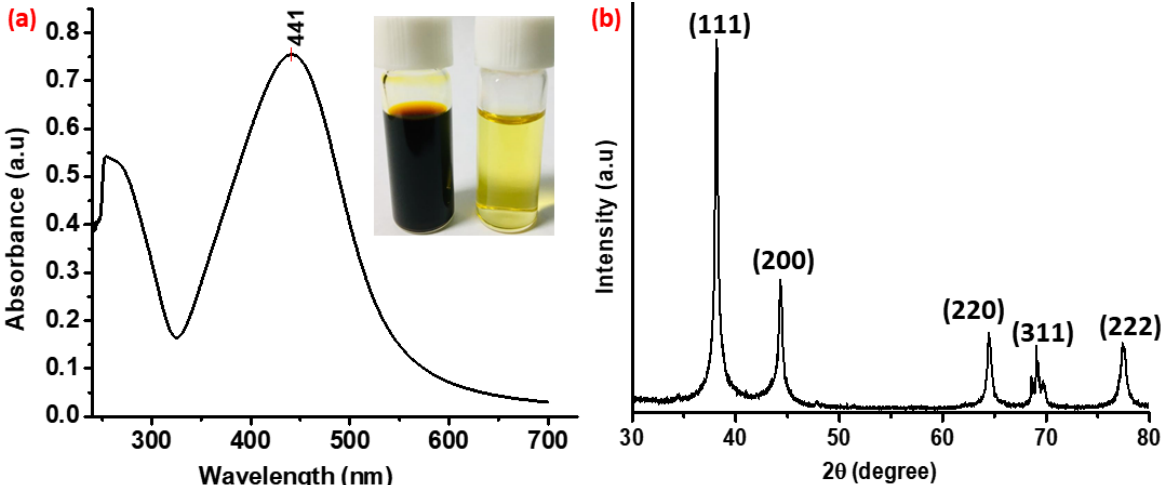
Figure 2. ( a ) UV–visible spectrum of the nanoparticle dispersion. The inset is the corresponding optical images of concen- trated (~2300 ppm, left) and diluted (~50 ppm, right) aqueous dispersions of silver nanocomposites; and ( b ) the XRD pattern of highly crystalline synthesized silver nanocomposites.